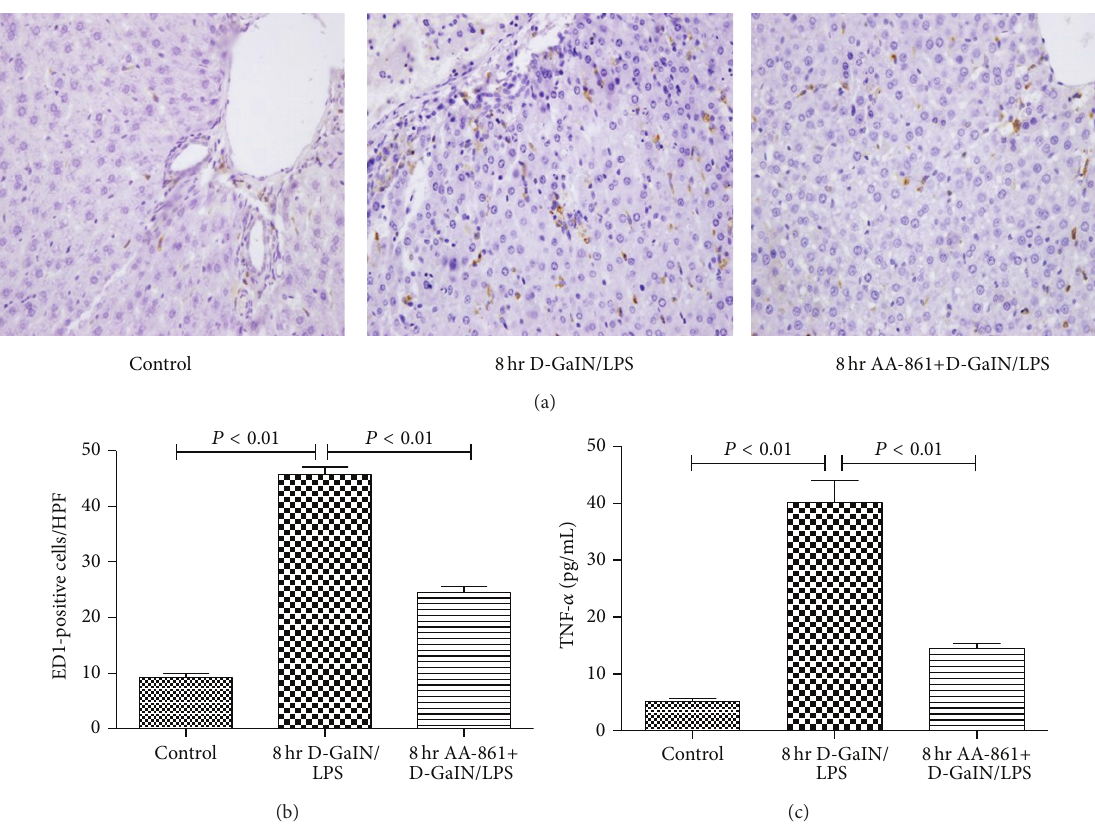
Figure 5: AA-861 significantly abrogated the increased number of ED1-positive cells in liver and increased level of TNF- 𝛼 in serum from D- GalN/LPS-treated rats. (a) Representative photomicrographs (400x) of liver sections immunostained with ED1 antibody from control (upper left panel) and 8-hr D-GalN/LPS-treated rats receiving placebo (middle panel) or AA-861 (right panel). A representative number of ED1- positive cells (Kupffer cells) are denoted by arrows. In D-GalN/LPS-treated rats, ED1-positive cells were located mainly in the midzonal area surrounding the damaged perivenular area. (b) The number of ED1-positive cells per HPF in liver tissue sections from control (left bar) and D-GalN/LPS-treated animals receiving placebo (middle bar) or AA-861 (right bar) for 8 hr. (c) The level of TNF- 𝛼 in serum from control (left bar) and D-GalN/LPS-treated animals receiving placebo (middle bar) or AA-861 (right bar) for 8hr. Results are expressed as mean ± standard error.